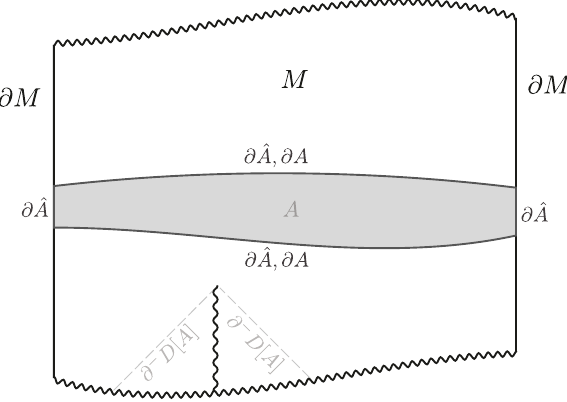
Figure 4 . An example of an asymptotically AdS spacetime M with conformal boundary ∂M , and with set A ⊂ M marked. The boundaries of A , ∂A in M and ∂ ˆ A in M ∪ ∂M , are highlighted. Furthermore, the past Cauchy horizon of D [ A ] = D [ ∂A ] is